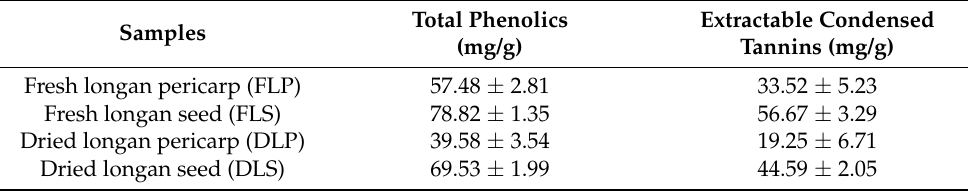
Table 1. TP and extractable condensed tannin contents in longan pericarps and